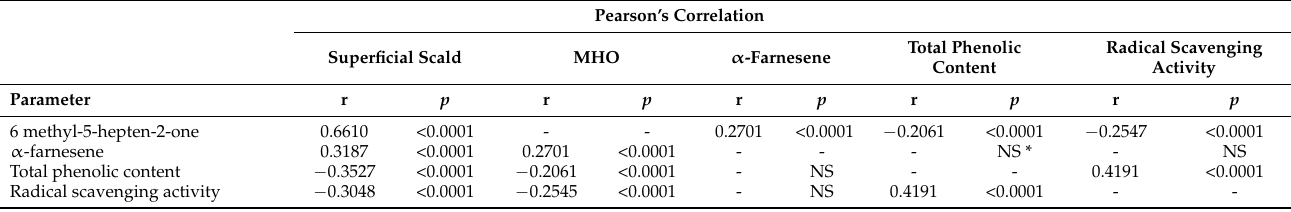
Table 3. Correlation of superficial scald and volatiles ( α -farnesene and MHO), total phenolic content, and total antioxi- dant